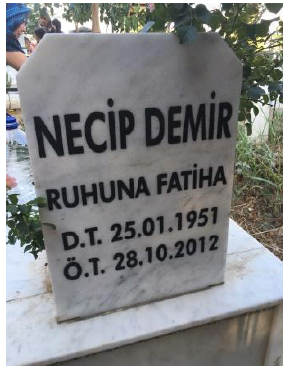
Figure 3. Showing a typical gravestone of Turkish, this gravestone belongs to the grave of Necip Demir (the father of Nusret Demir, first author of this article).